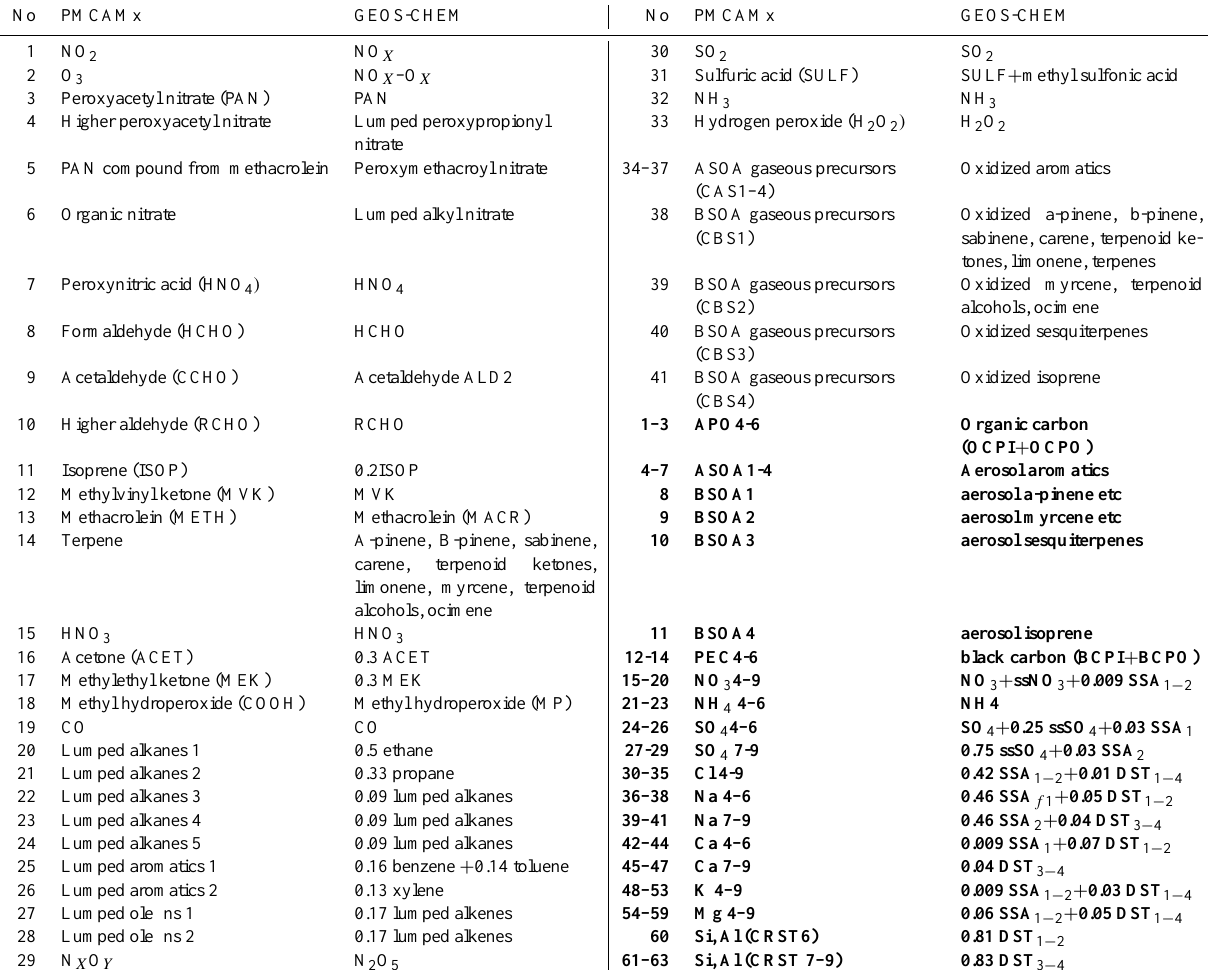
Table 2. The chemical coupling (in ppb) between the PMCAMx (SAPRC, ISORROPIAII and VBS mechanisms) and the GEOS-CHEM (SOA mechanism) model. Aerosols are shown in bold. The numbers next to PMCAMx aerosol species correspond to their size bins. PM 2 . 5 in PMCAMx corresponds to the bins 1 to 6, while the rest of the bins (7 to 10) are PM 2 . 5 − 40 . Sea-salt aerosols (SSA) in GEOS-CHEM are simulated in two bins (effective diameter ranges 0.2 to 5 and 5 to 8µm), while dust particles (DST) are split into 4 bins (effective diameters 1.4, 2.8, 4.8 and